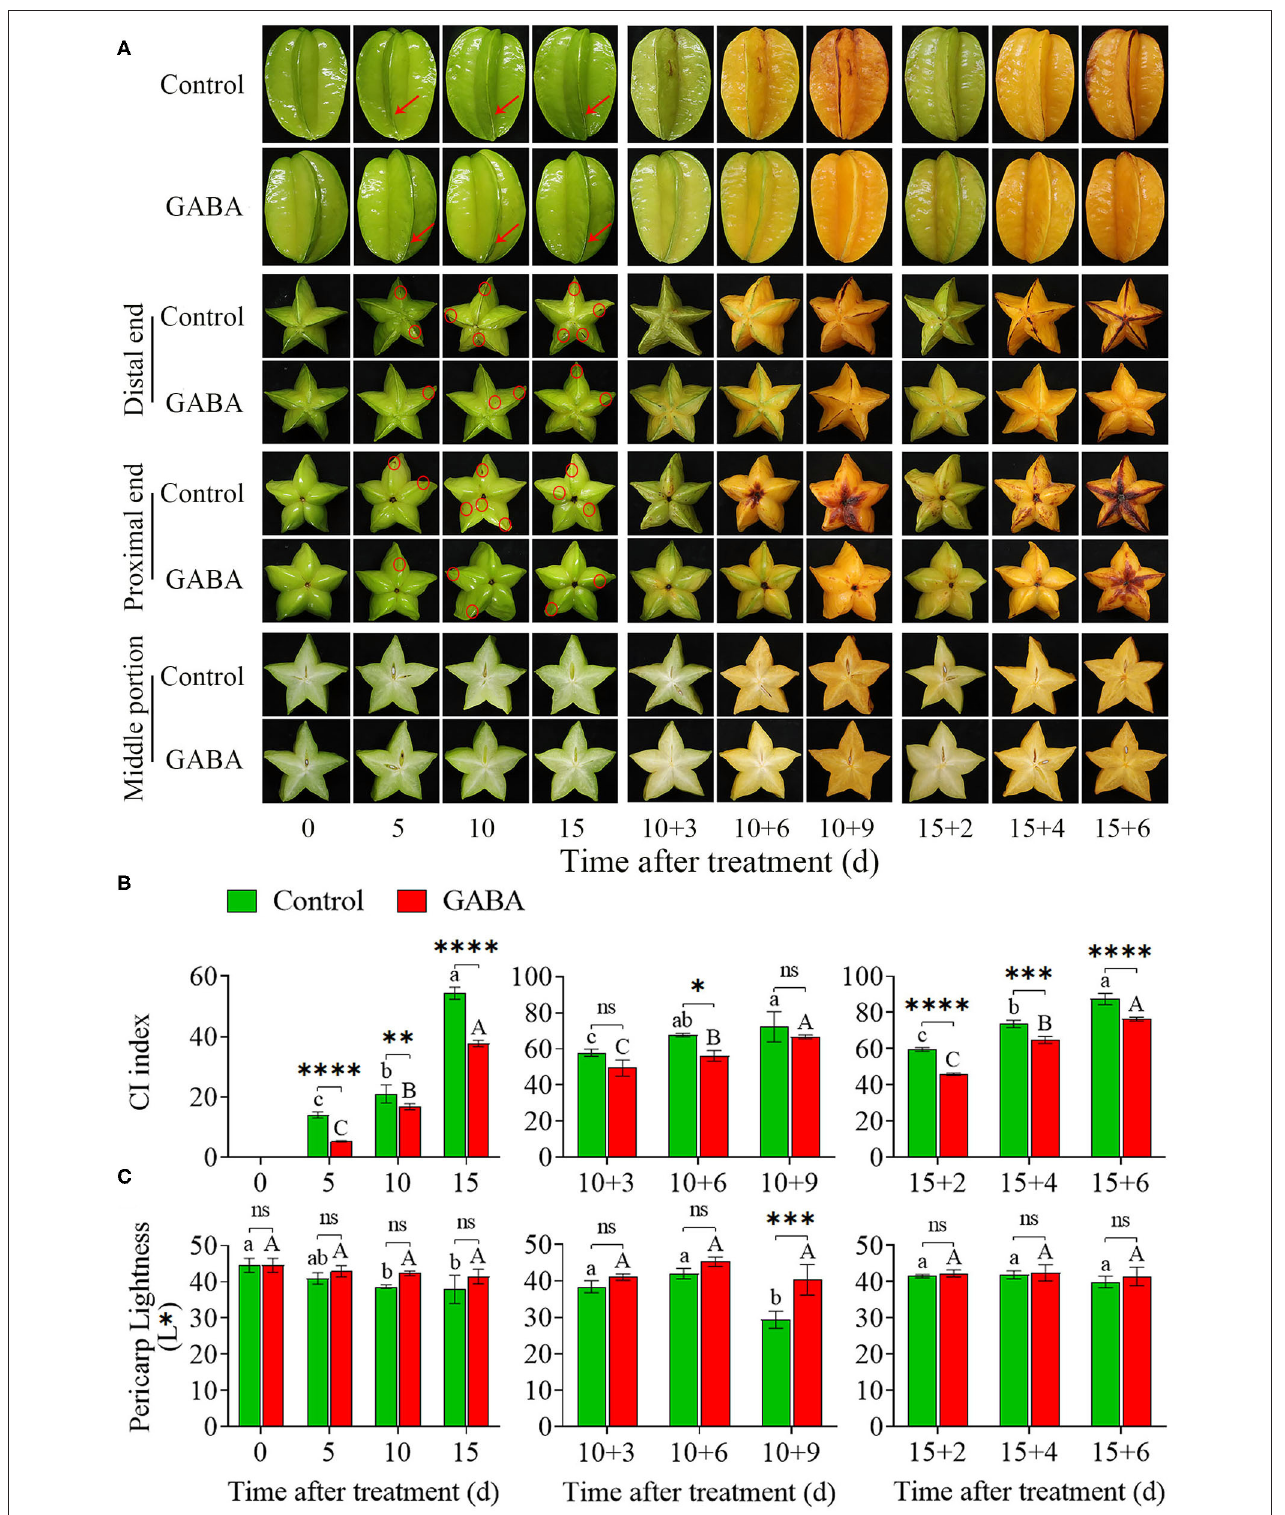
FIGURE 1 | Visual appearance of CI symptoms of carambola fruit during storage at 4 and 25 ◦ C (A) , CI index (B) , and pericarp lightness (C) . Error bars are expressed as means ± SD (standard deviation) of three replicates ( n = 3). The asterisks indicate statistically significant differences between treatments at * p < 0.05, ** p < 0.01, *** p < 0.001, **** p < 0.0001, ns, no significant.